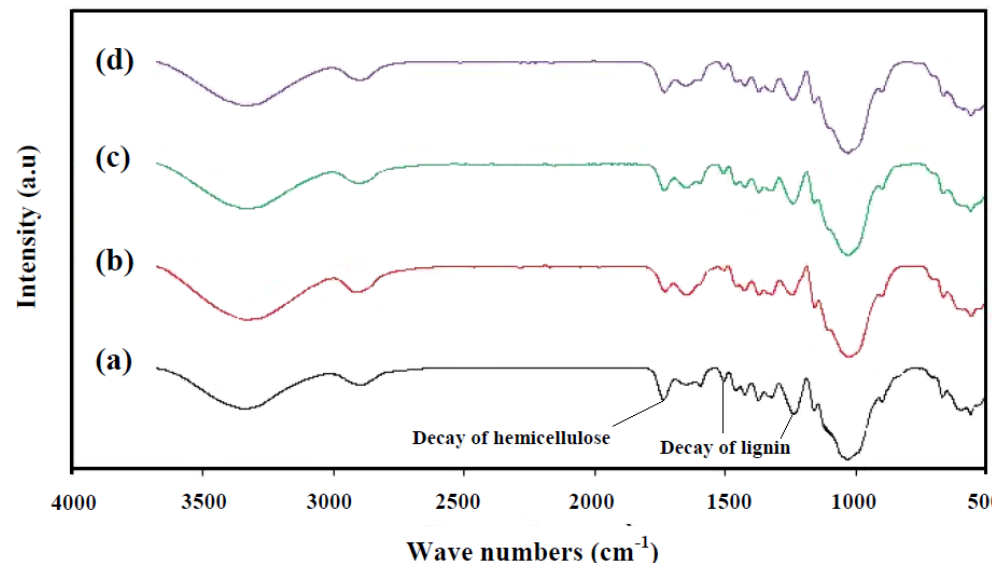
Figure 3. FT-IR spectra of undecayed and decayed rubberwood samples by white rot fungi: ( a ) undecayed wood; (b ) decayed by mixed culture; ( c ) decayed by T. versicolo ; ( d ) decayed by C.subvermispora for 90